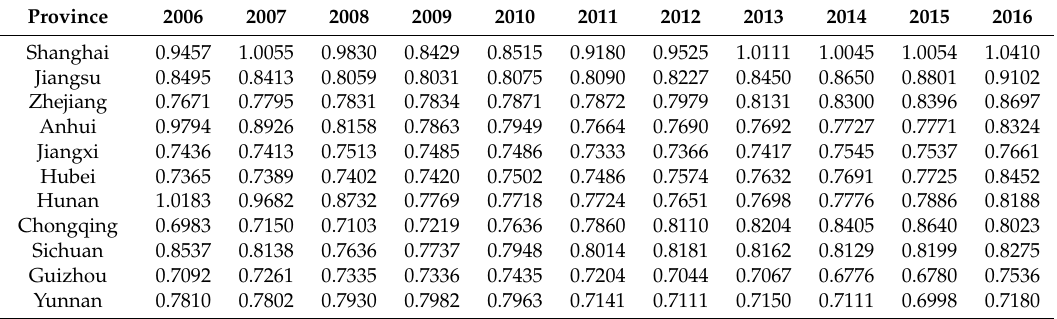
Table 1. Results of interprovincial water resource utilization efficiency in the Yangtze River Economic Belt considering undesirable